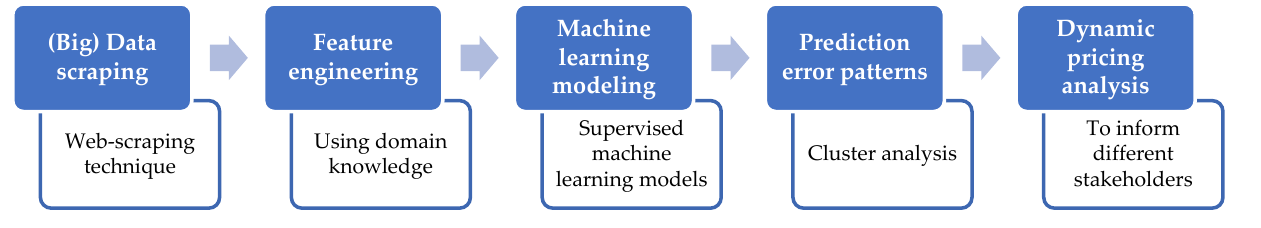
Figure 5. Methodological framework.